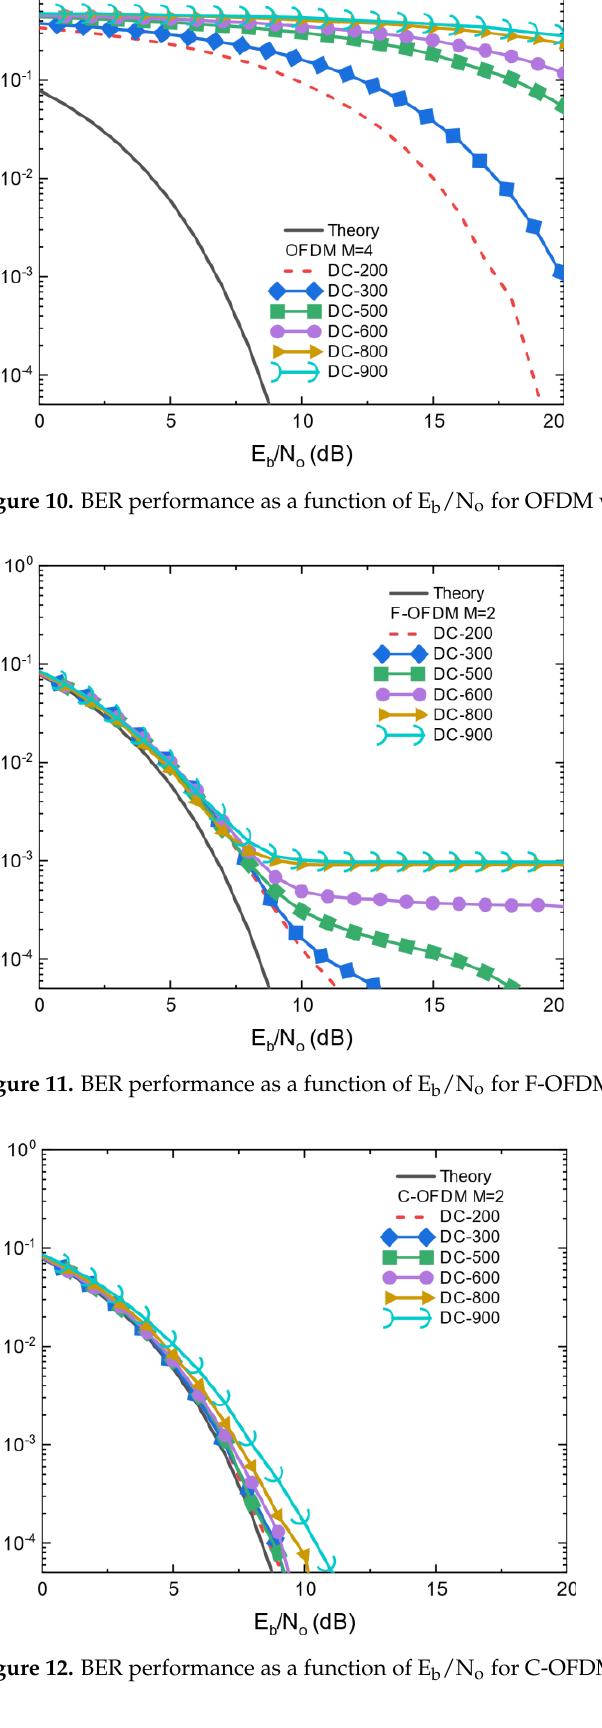
Figure 12. BER performance as a function of E b /N o for C-OFDM with 2-PAM and 600 AC.